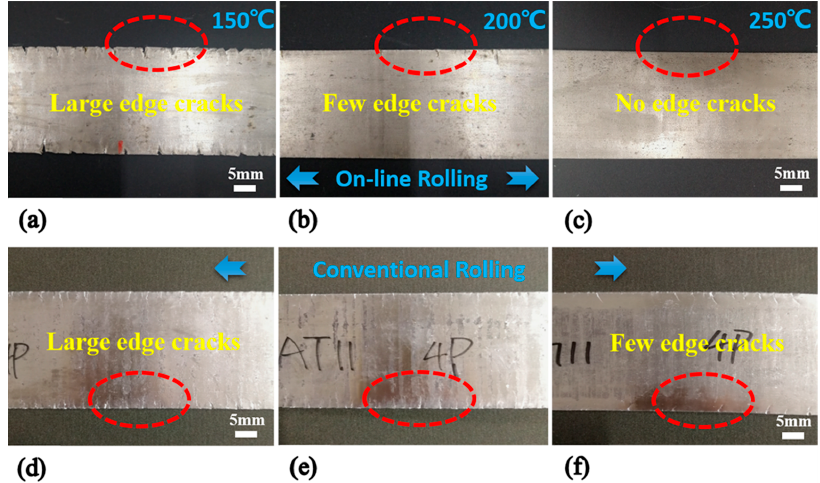
Figure 3. The appearance of the rolled sheets using on-line heating at different temperatures: ( a ) 150 °C, ( b ) 200 °C, and ( c ) 250 °C. The appearance of the rolled sheets using conventional rolling at different temperature: ( d ) 150 °C, ( e ) 200 °C, and ( f ) 250 °C.